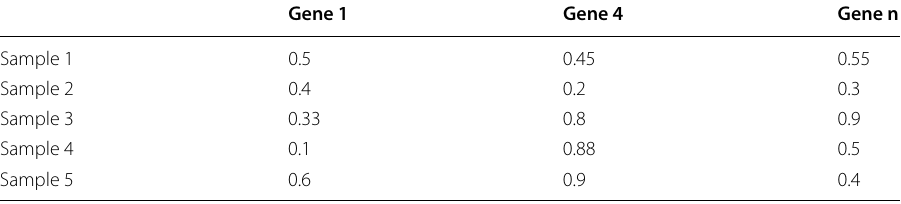
Table 5 Example of selected gene